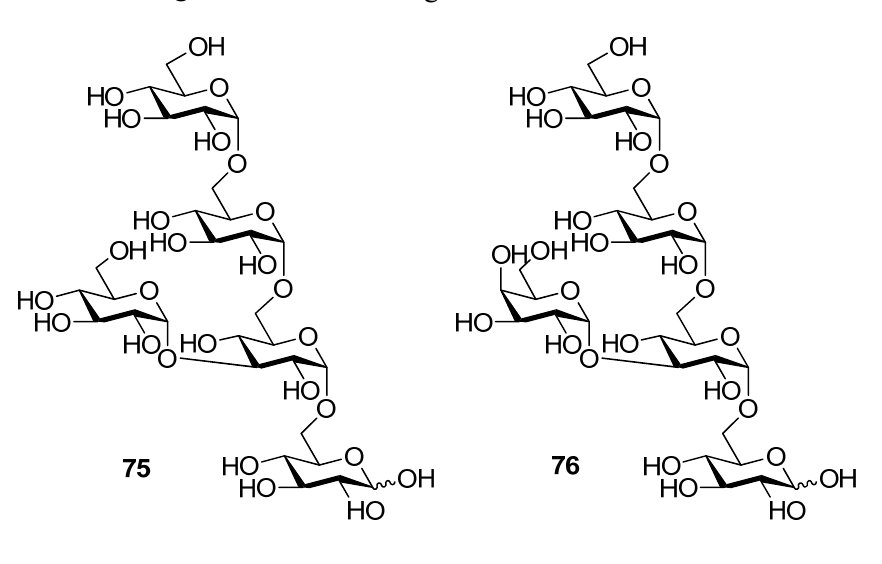
Figure 1. Branched oligosaccharides 75 and 76